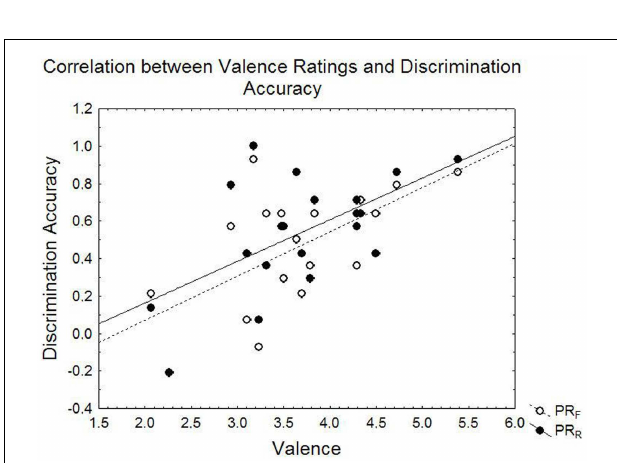
FIGURE 5 | Illustration of the linear correlation between the magnitude of DF (in terms of recognition accuracy Pr) and scores on the dissociative experience scale (DES) .